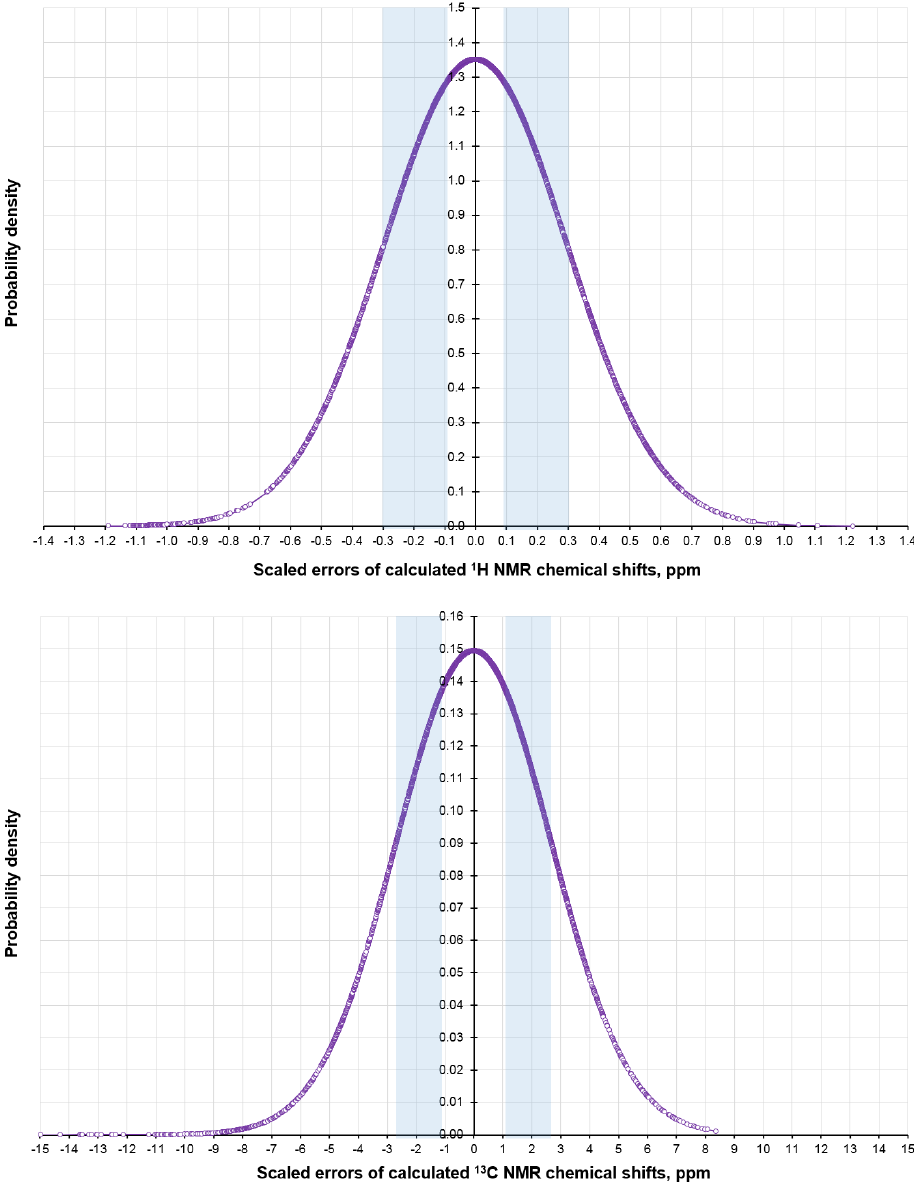
Figure 11. Normal distribution plots of scaled 1 H (top) and 13 C (bottom) NMR chemical shift errors.